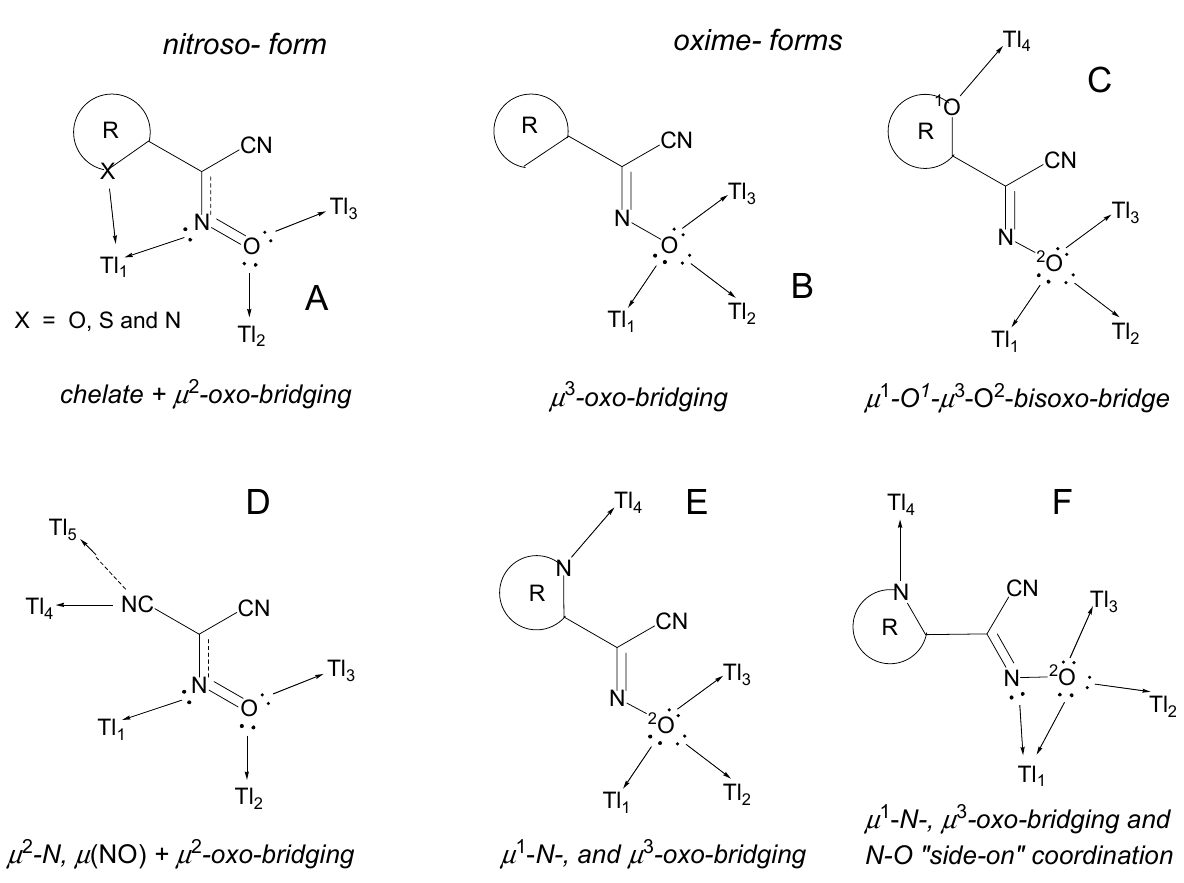
Figure 5. Organization of a zigzag chain in 2D-coordination polymer in the structure of Tl(BCO). H-atoms are omitted for